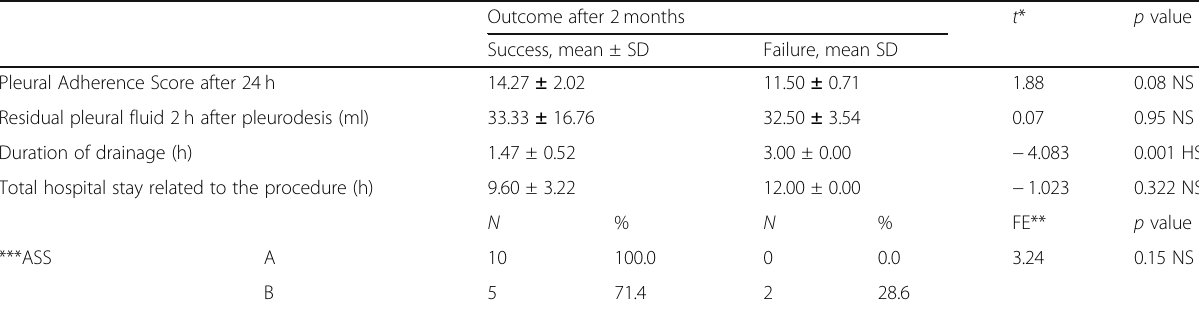
Table 4 Factors affecting the outcome